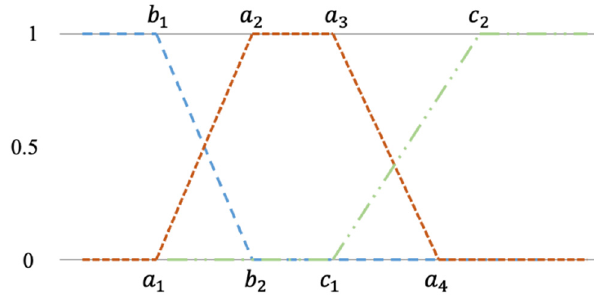
Figure 2. Membership functions and